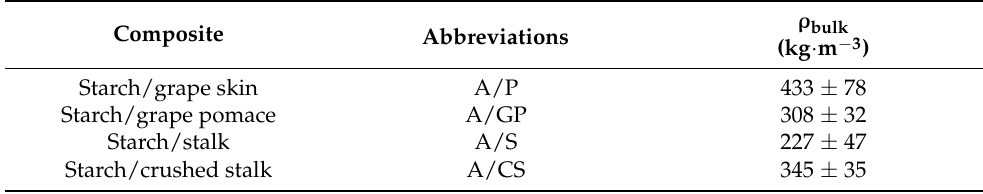
Table 1. Bulk density of composites with 20% starch.